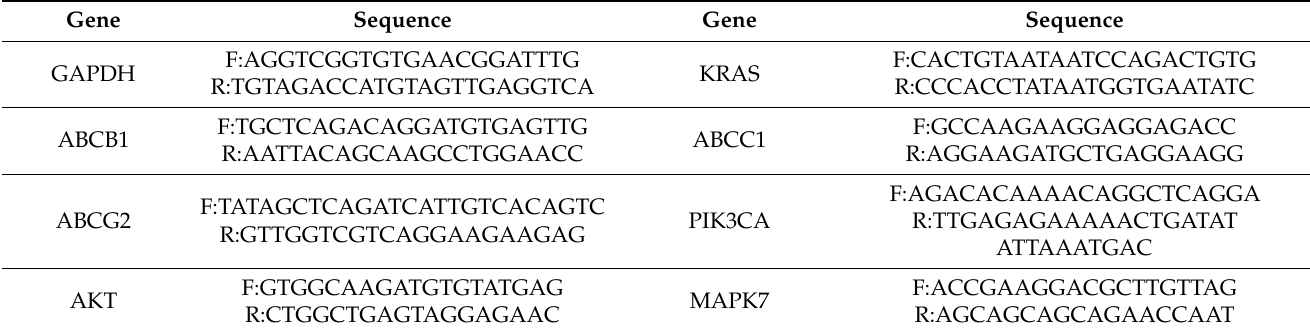
Table 7. Sequence of GAPDH, KRAS, ABCB1, ABCC1, ABCG2, PIK3CA, AKT, and MAPK7 primers.